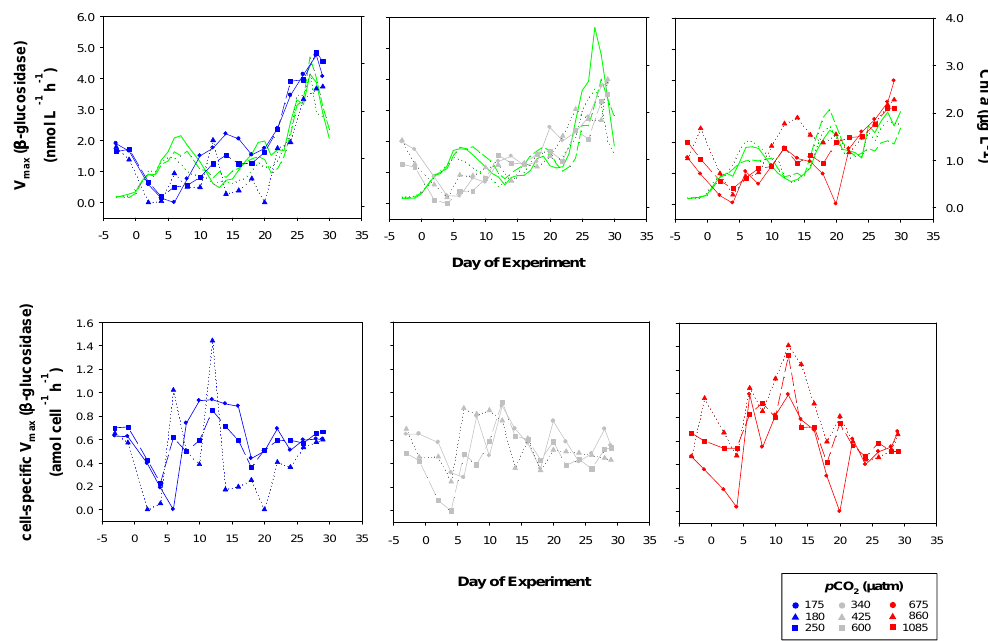
Fig. 4. Temporal development of extracellular β -glucosidase activity in mesocosms of low (175–250µatm; blue symbols), medium (340– 600µatm; grey symbols), and high p CO 2 (675–1085µatm; red symbols). Maximum reaction velocities ( V max ) are normalised to volume (nmolL − 1 h − 1 ; upper panel) and bacterial abundance (amolcell − 1 h − 1 ; lower panel). Green lines represent chlorophyll a (Chl a) concen- trations in the mesocosms.